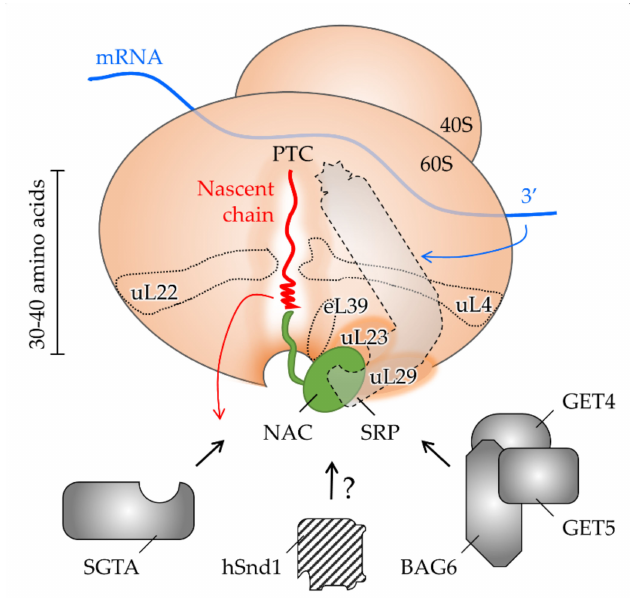
Figure 4. The impact of ribosome-binding proteins and the ribosomal exit tunnel geometry on the nascent chain and targeting decision. The nascent chain (red line) is born at the peptidyl transferase center (PTC) and folds in the vestibule of the lower ribosomal tunnel after passing the constriction sites build by the universally conserved ribosomal proteins uL22 and uL4 (dotted lines). Early recruitment of targeting factors involves the mRNA (blue line) and the presence and folding of the nascent chain while still residing inside the tunnel (blue and red arrow, respectively). Ribosomal surface proteins such as uL23 and uL29 (orange) which build common docking sites are mapped next to the exit port. Moreover, eL39 (dotted ellipse) that lines the interior of the ribosomal